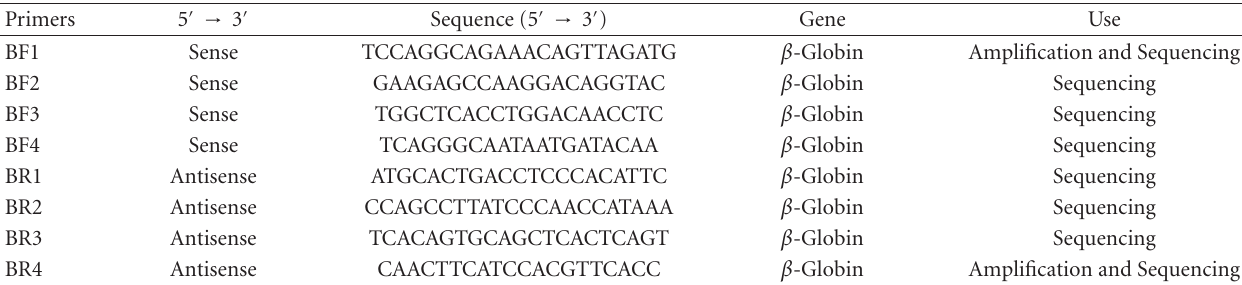
Table 1: Oligonucleotide primers used in this